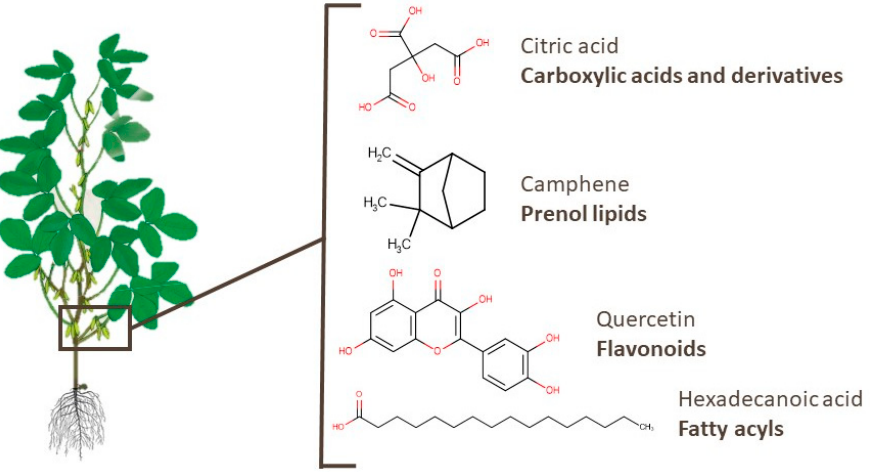
Figure 8. Chemical structures of citric acid, camphene, quercetin, and hexadecanoic acid, which are examples of bioactive compounds identified in soy pods.